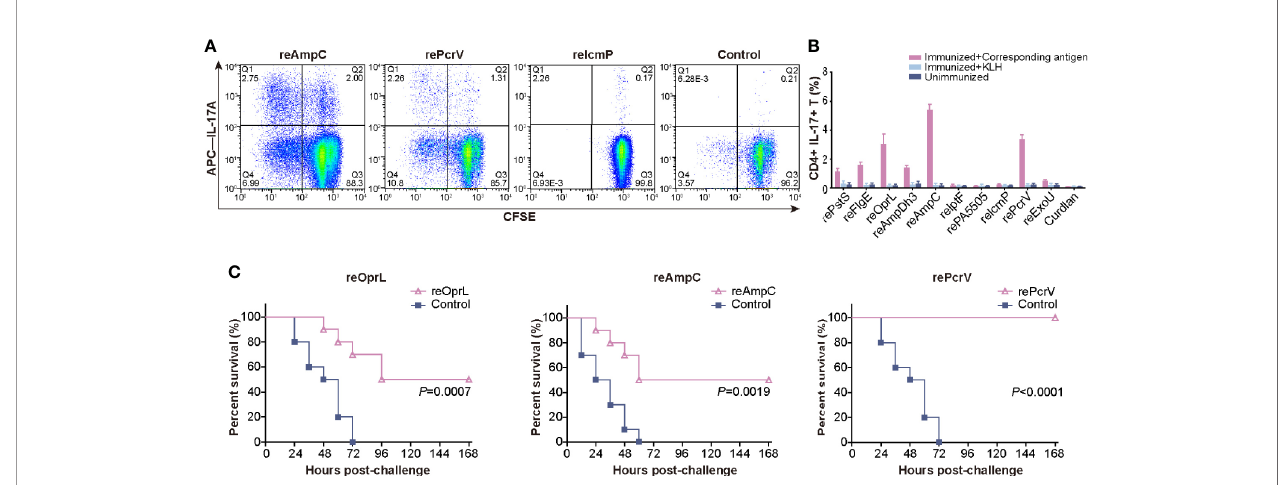
FIGURE 1 | Screening for protective antigens that can induce a Th17 response. (A) Mice (n = 5) were intranasally immunized with the ten puri fi ed recombinant proteins, and lung lymphocytes were isolated and costimulated with the corresponding antigens. The representative dot plots show the frequency of CD4 + IL-17A + T cells among lung lymphocytes from mice immunized with reAmpC, rePcrV, reIcmP, and the adjuvant curdlan. (B) The bar represents the percentage of CD4 + IL- 17A + T cells among lung lymphocytes from mice (n = 5) of the ten groups. The top three proteins were reAmpC (5.4%), rePcrV (3.4%) and reOprL (3.1%). (C) The survival of mice (n = 10) immunized with reOprL, reAmpC or rePcrV after challenge with a lethal dose of PA XN-1. All the immunized groups showed signi fi cantly better survival than did the